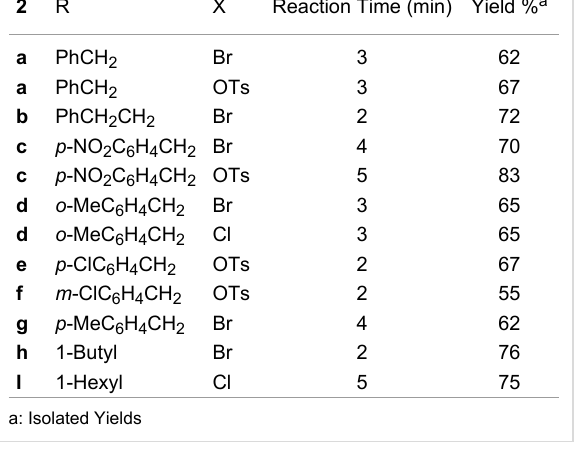
Table 1: Reaction of alkyl halides and tosylates in the presence of a mixture of triethyl amine/sulfure/alumina with diethylphosphite under solvent-free conditions